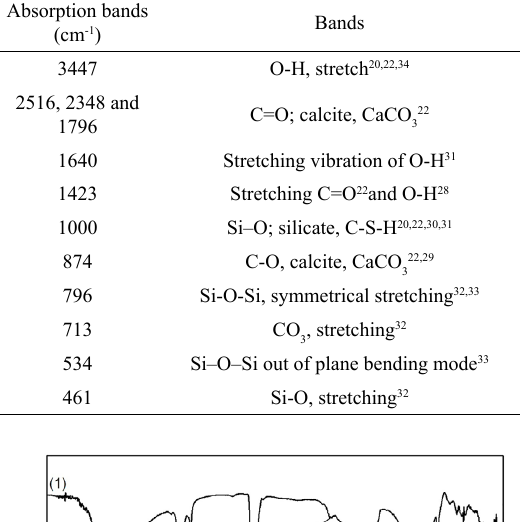
Table 3. Characteristics of U-GCW FTIR spectrum. Absorption bands (cm -1 )